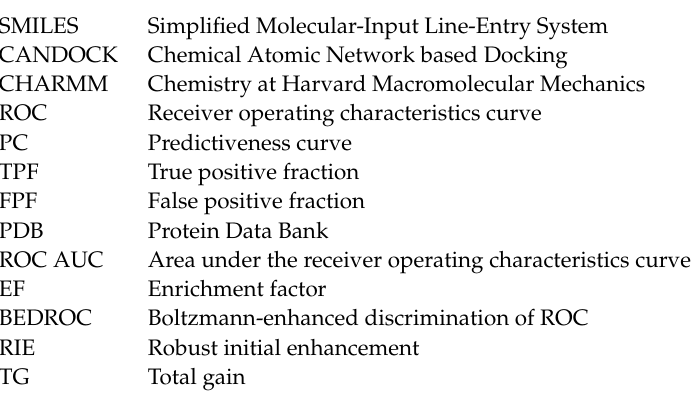
target. Table S2: Best docking scores for carnosol, carnosic acid and rosmanol. Table S3: Best docking scores for rosmarinic acid. Table S4–S24: Interaction of compounds with respective targets presented in Table 1; Table 2. The SwissADME output file can be found in the file swissadme_output.xlsx supplied as part of the Supplementary